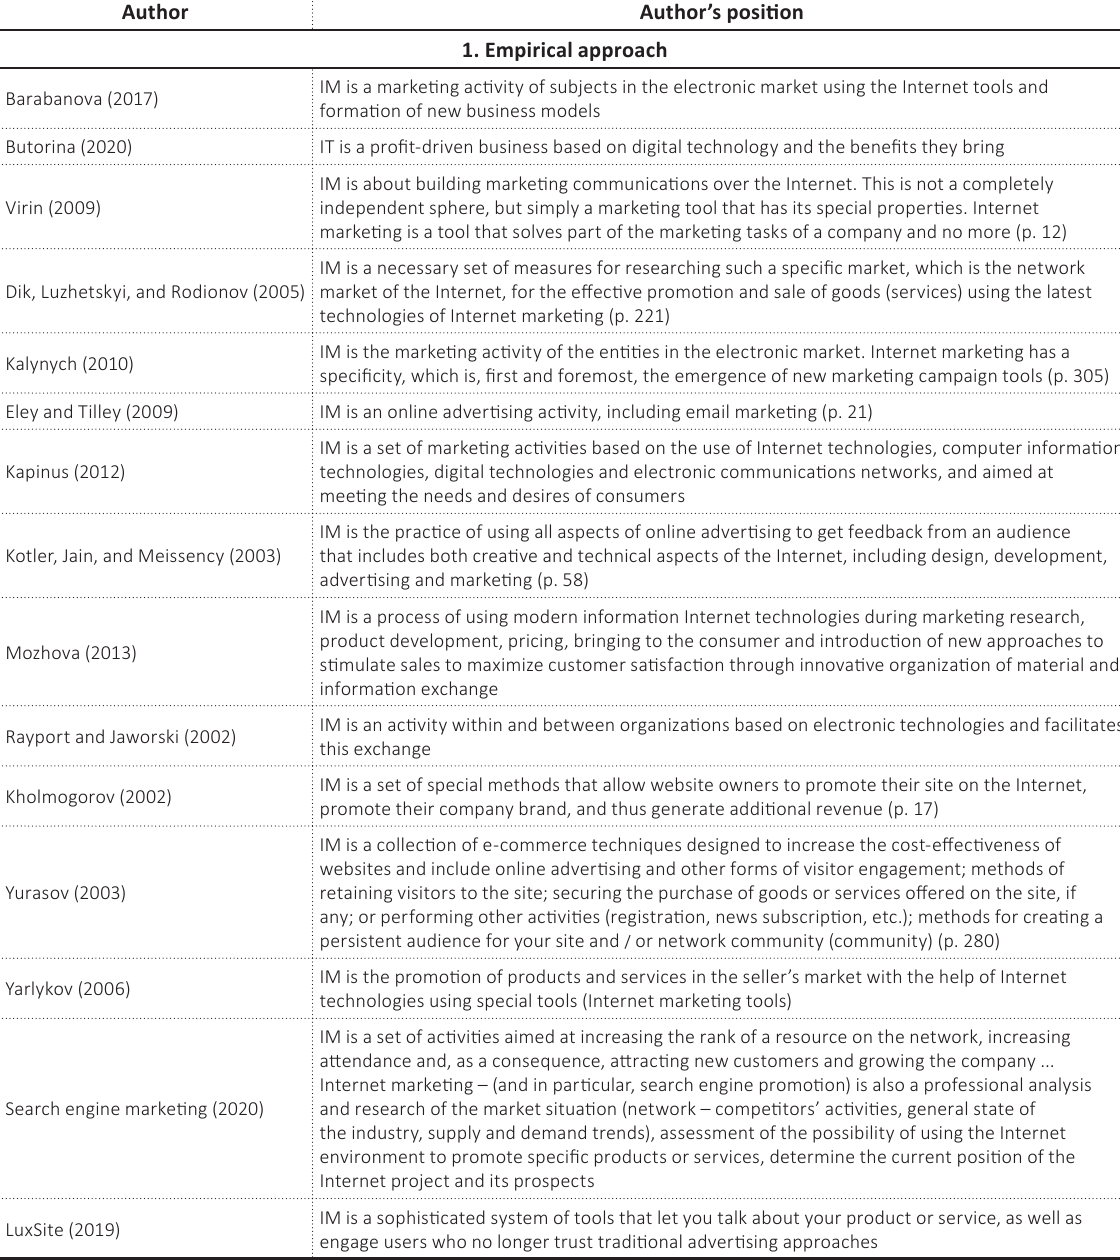
Table 2. The selected conceptual approaches of scientists and marketers to defining “Internet marketing”